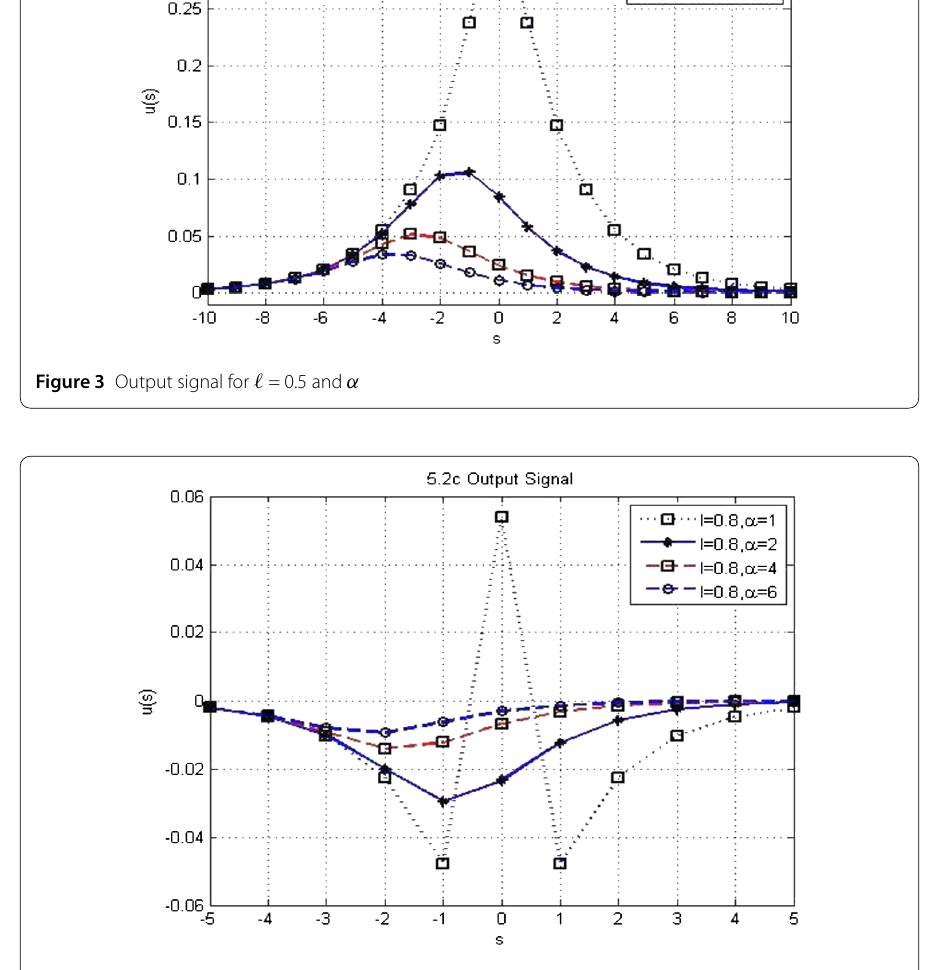
Figure 4 Output signal for (cid:5) = 0.8 and α